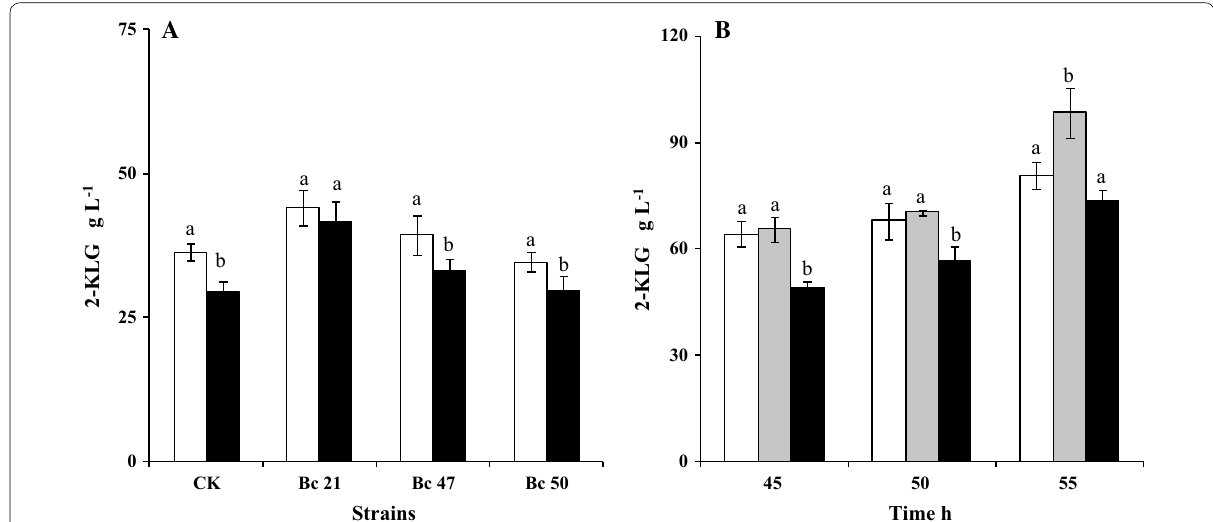
Fig. 5 The effect of l -sorbose-tolerant helper strain on the production of 2-KLG. A White bar: the concentration of 2-KLG produced by co-culturing l -sorbose-tolerant helper strain and K. vugare at 8% of l -sorbose in the medium; black bar: the concentration of 2-KLG produced by co-culturing l -sorbose-tolerant helper strain and K. vugare at 14% of l -sorbose in the medium; B White bar: the concentration of 2-KLG in 8% l -sorbose, gray bar: the concentration of 2-KLG in 11% l -sorbose; black bar: the concentration of 2-KLG in 14% l -sorbose. The same letters (a, b and c) in the bar denote treatments are not significantly different (P >